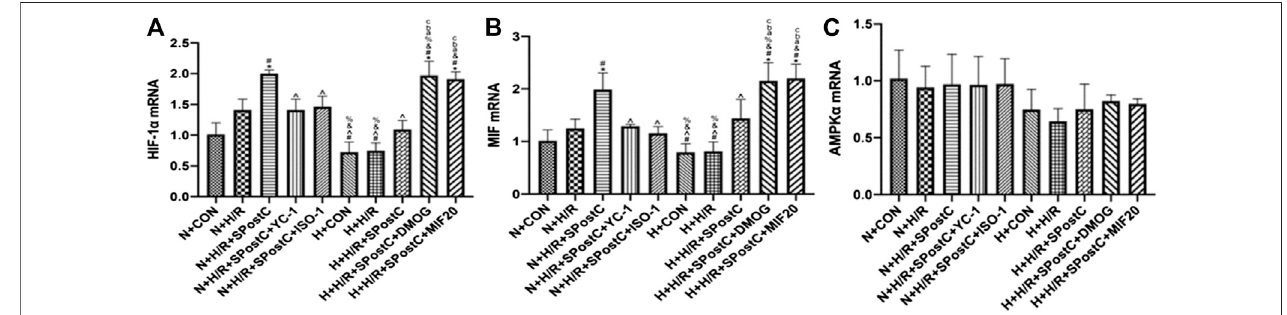
FIGURE 3 | The effect of SPostC on the mRNA expression of HIF-1 α , MIF and AMPK α in the H/R injury of cardiomyocytes under low glucose and high glucose conditions. (A) ThemRNAexpressionofHIF-1 α . (B) ThemRNAexpressionofMIF. (C) ThemRNAexpressionofAMPK α .Datarepresentmean ± SD,vs.N+CONgroup * p < 0.05;vs.N+H/Rgroup # p < 0.05;vs.N+H/R+SPostCgroup ^ p < 0.05;vs.N+H/R+SPostC+YC-1group & p < 0.05;vs.N+H/R+SPostC+ISO-1group% p < 0.05; vs. H + CON group a P < 0.05; vs. H + H/R group b P < 0.05; vs. H + H/R + SPostC group c P <